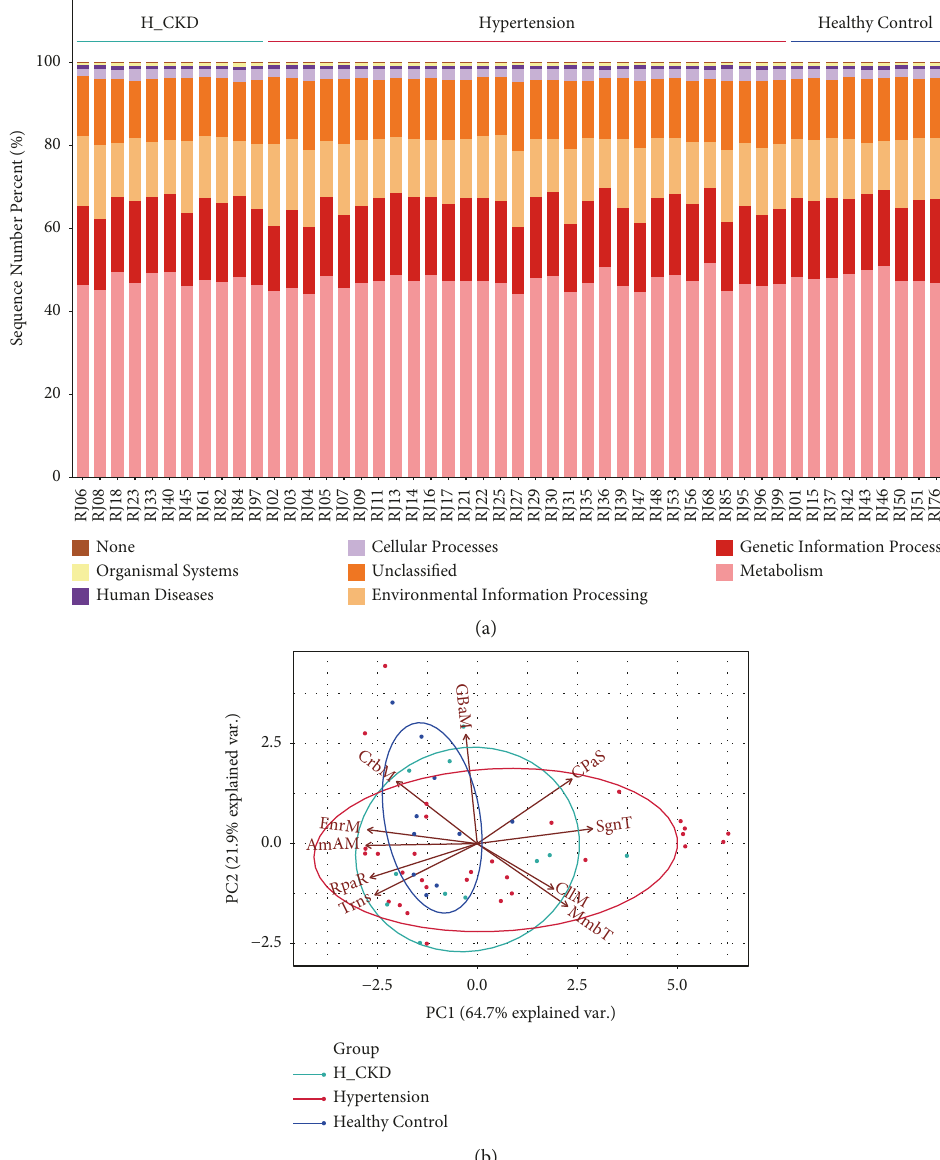
Figure 6: Predicted metagenomes functional analysis by PICRUSt. (a) Bar chart shows that different relative abundance predicted function of gut bacteria in all individuals on the first KEEG pathway level and (b) predicted functions on the second KEEG pathway level. PC1 represents the first principal component, and the percentage represents the contribution of the first principal component to the sample difference; PC2 represents the second principal component, and the percentage represents the contribution of the second principal component to the sample difference (PC1:64.7%; PC2: 21.9%). The direction and length of the arrow represent the degree of dominance of the prediction functions in the sample/group in that direction, the longer the length, the stronger the dominance. CPaS: cellular processes and signaling; Trns: translation; EnrM: energy metabolism; RpaR: replication and repair; AmAM: amino acid metabolism; CrbM: car- bohydrate metabolism; MmpT: membrane transport; SgnT: signal transduction; MmbT: membrane transport; CllM: cell motility GBaM: glycan biosynthesis and metabolism; EnrM: energy